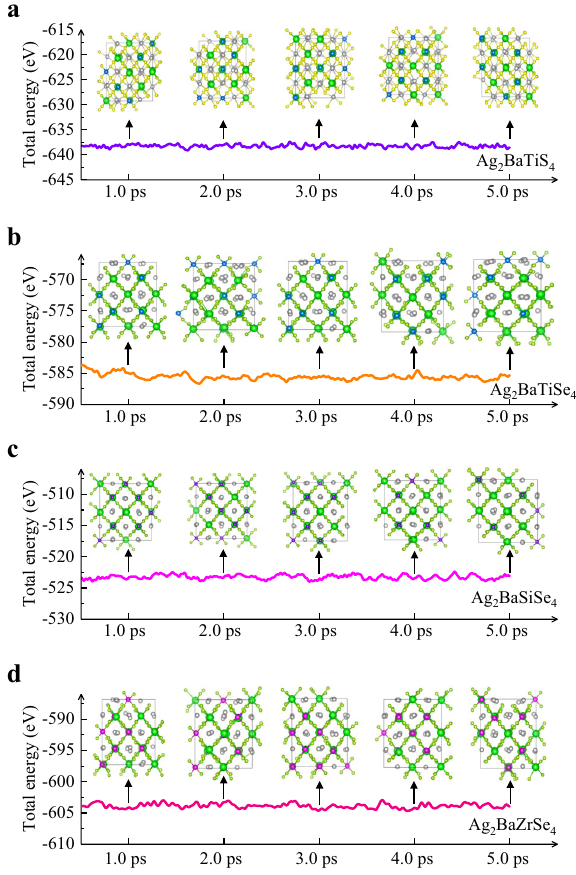
Fig. 7 Evaluations of thermodynamic stabilities of four I 2 -II-IV-X 4 chalcogenides by AIMD. a Ag 2 BaTiS 4 , b Ag 2 BaTiSe 4 , c Ag 2 BaSiSe 4 , d Ag 2 BaZrSe 4 . The thermodynamic stabilities of other four I 2 -II-IV-X 4 chalcogenides are provided in Supplementary Fig. 26. The total energy of each step and the crystal structures of each ps are also